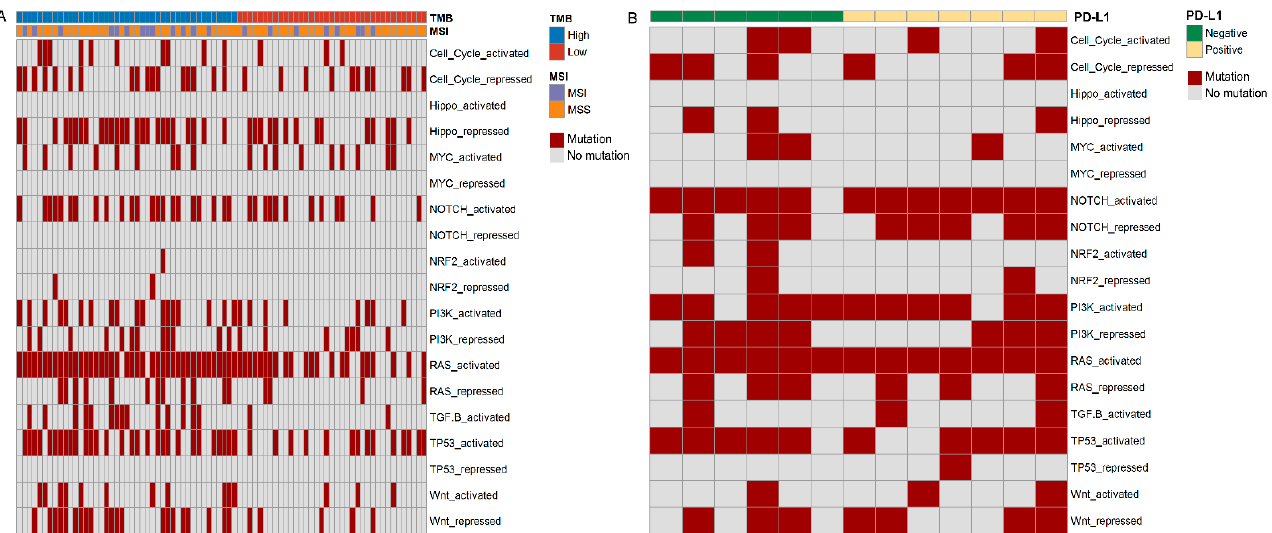
Figure 4. Analysis of immune-related pathway. ( A ) Heatmap depicting immune-related pathway of all mutated genes in group 1. There were 15 kinds of immune-related pathway among these genes that were mutated in group 1. ( B ) Heatmap showing immune-related pathway of all mutated genes in group 2. These mutated genes were involved in 17 categories of immune-related pathway.